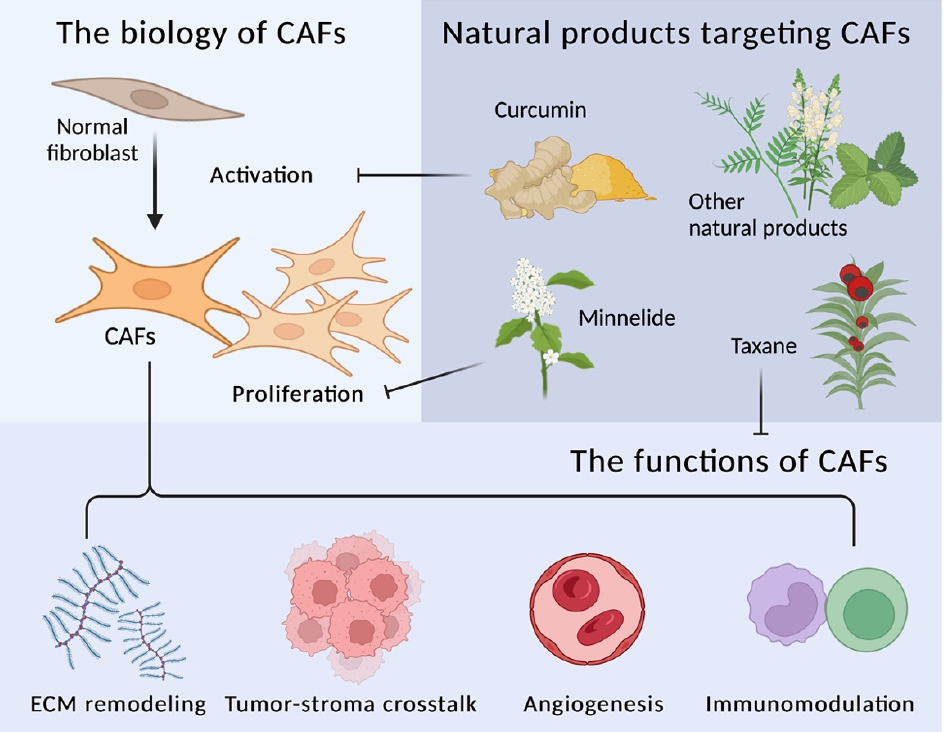
Figure 1. The therapeutic insights of natural compounds targeting CAFs (cancer-associated fibroblasts). CAFs in the TME (tumor microenvironment) are the critical contributor of tumorigenesis, cancer progression, and metastasis. The therapeutic strategies targeting CAFs are still flourishing. Several natural products have been discovered to have the potential to inhibit CAFs activation, proliferation, and tumor-promoting functions.